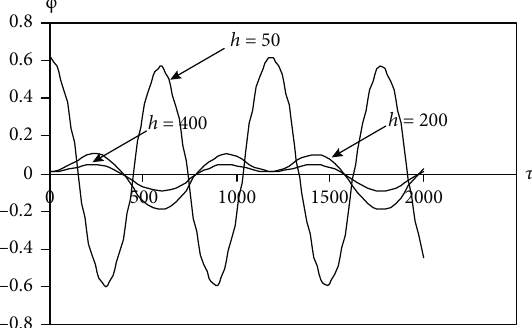
Figure 3: The analytical and numerical angular velocities φ ′ against τ at h = 400 , 200, and